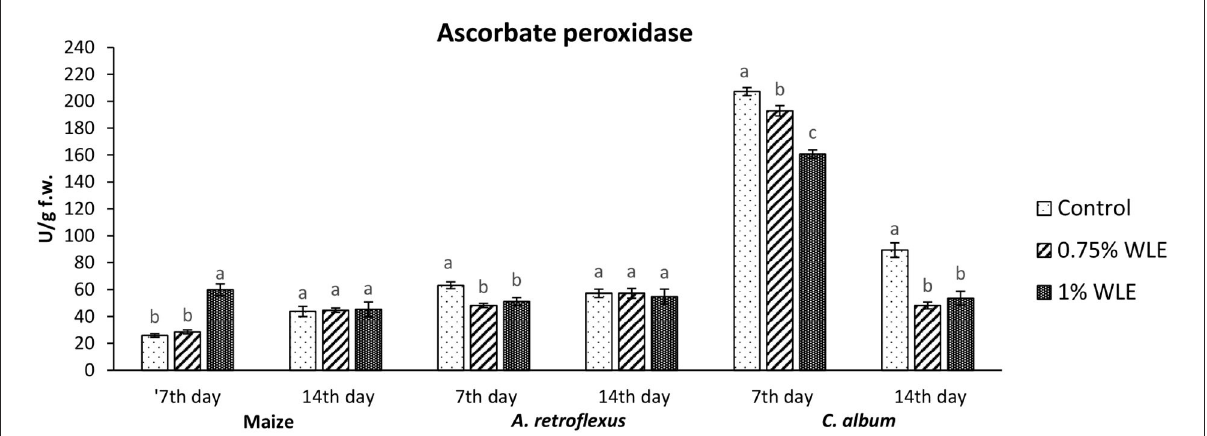
FIGURE5 Activity of antioxidant enzyme ascorbate peroxidase (APX) in maize and weeds - Amaranthus retroflexus and Chenopodium album as a response to treatment with 0.75 and 1% walnut leaf extract, on the 7 th and 14 th day after treatment. Data are presented as mean ± SD. Values marked with